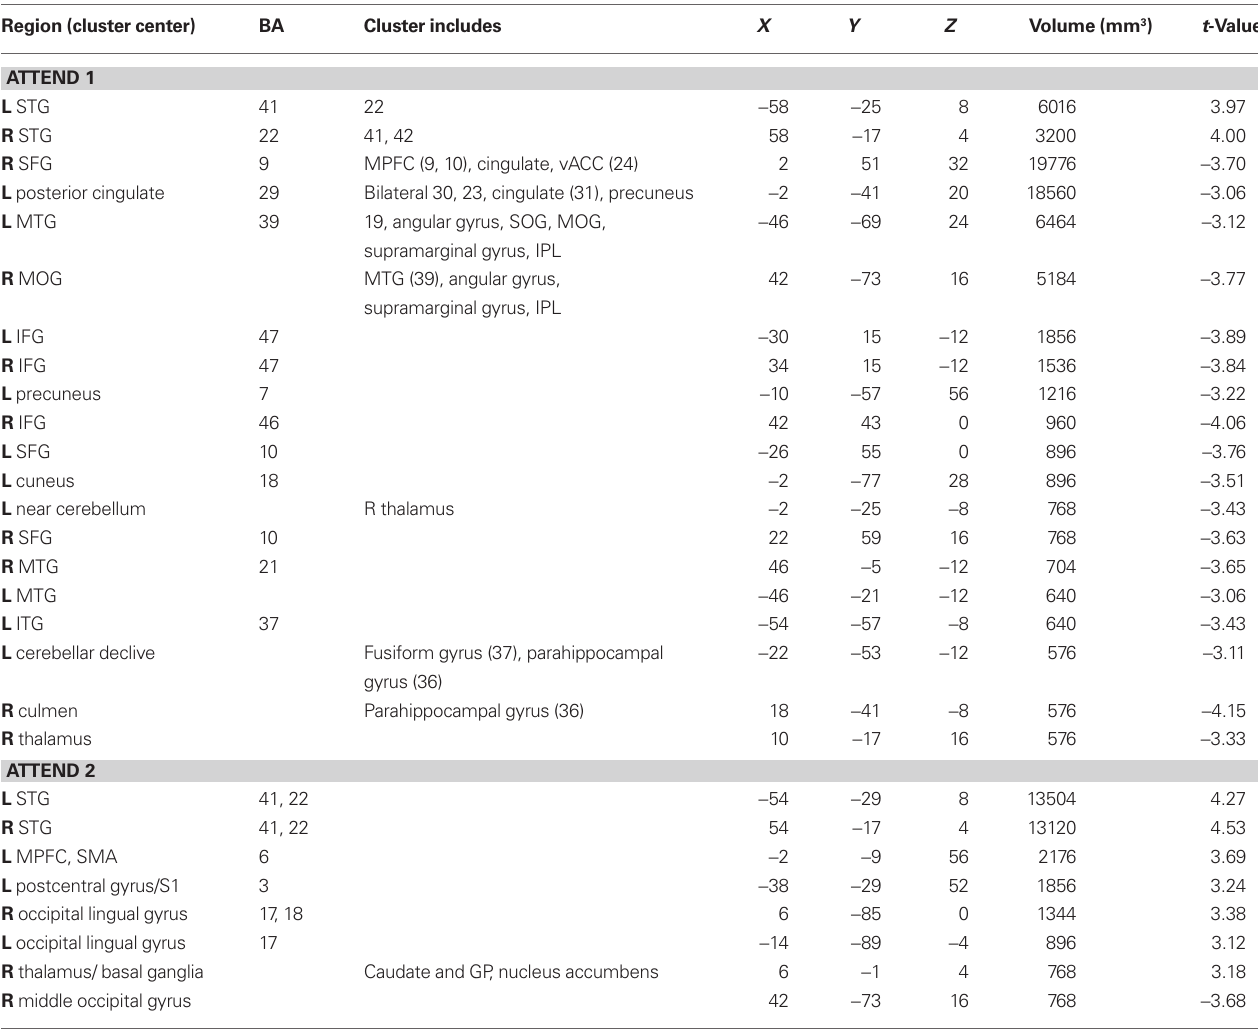
Table 1 | Auditory attend activations compared to rest ( p < 0.002 corrected). Region (cluster